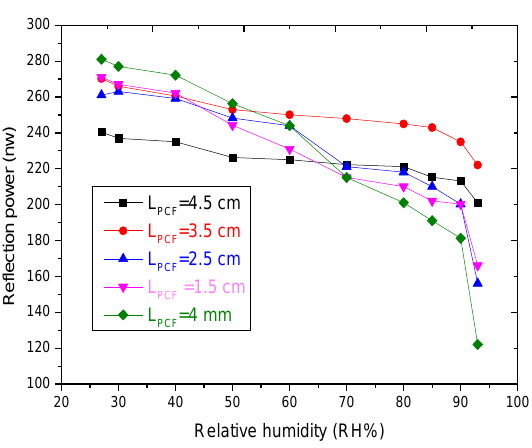
Fig. 4: Interference peaks shift of PCFI with respect humidity of the different lengths .